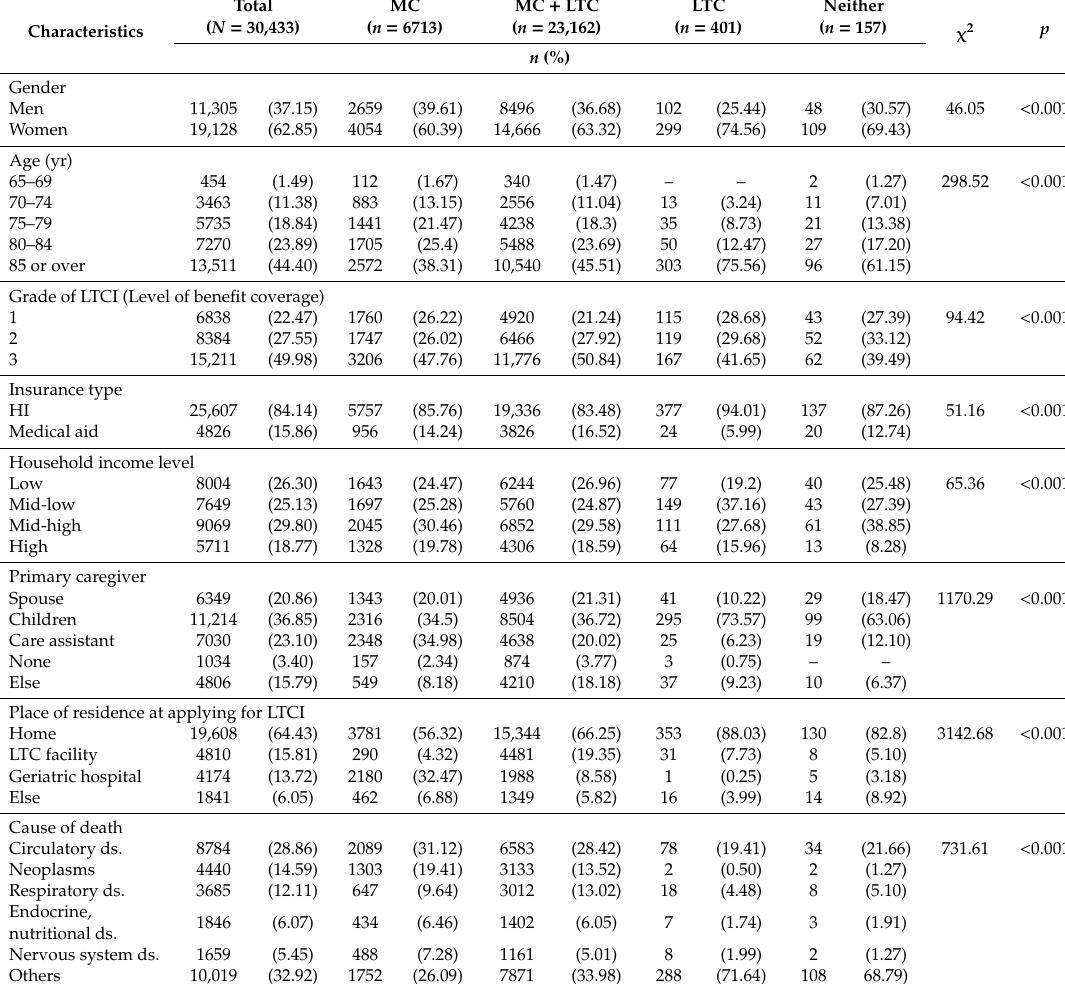
Table 2. Characteristics of subjects by pattern of medical care